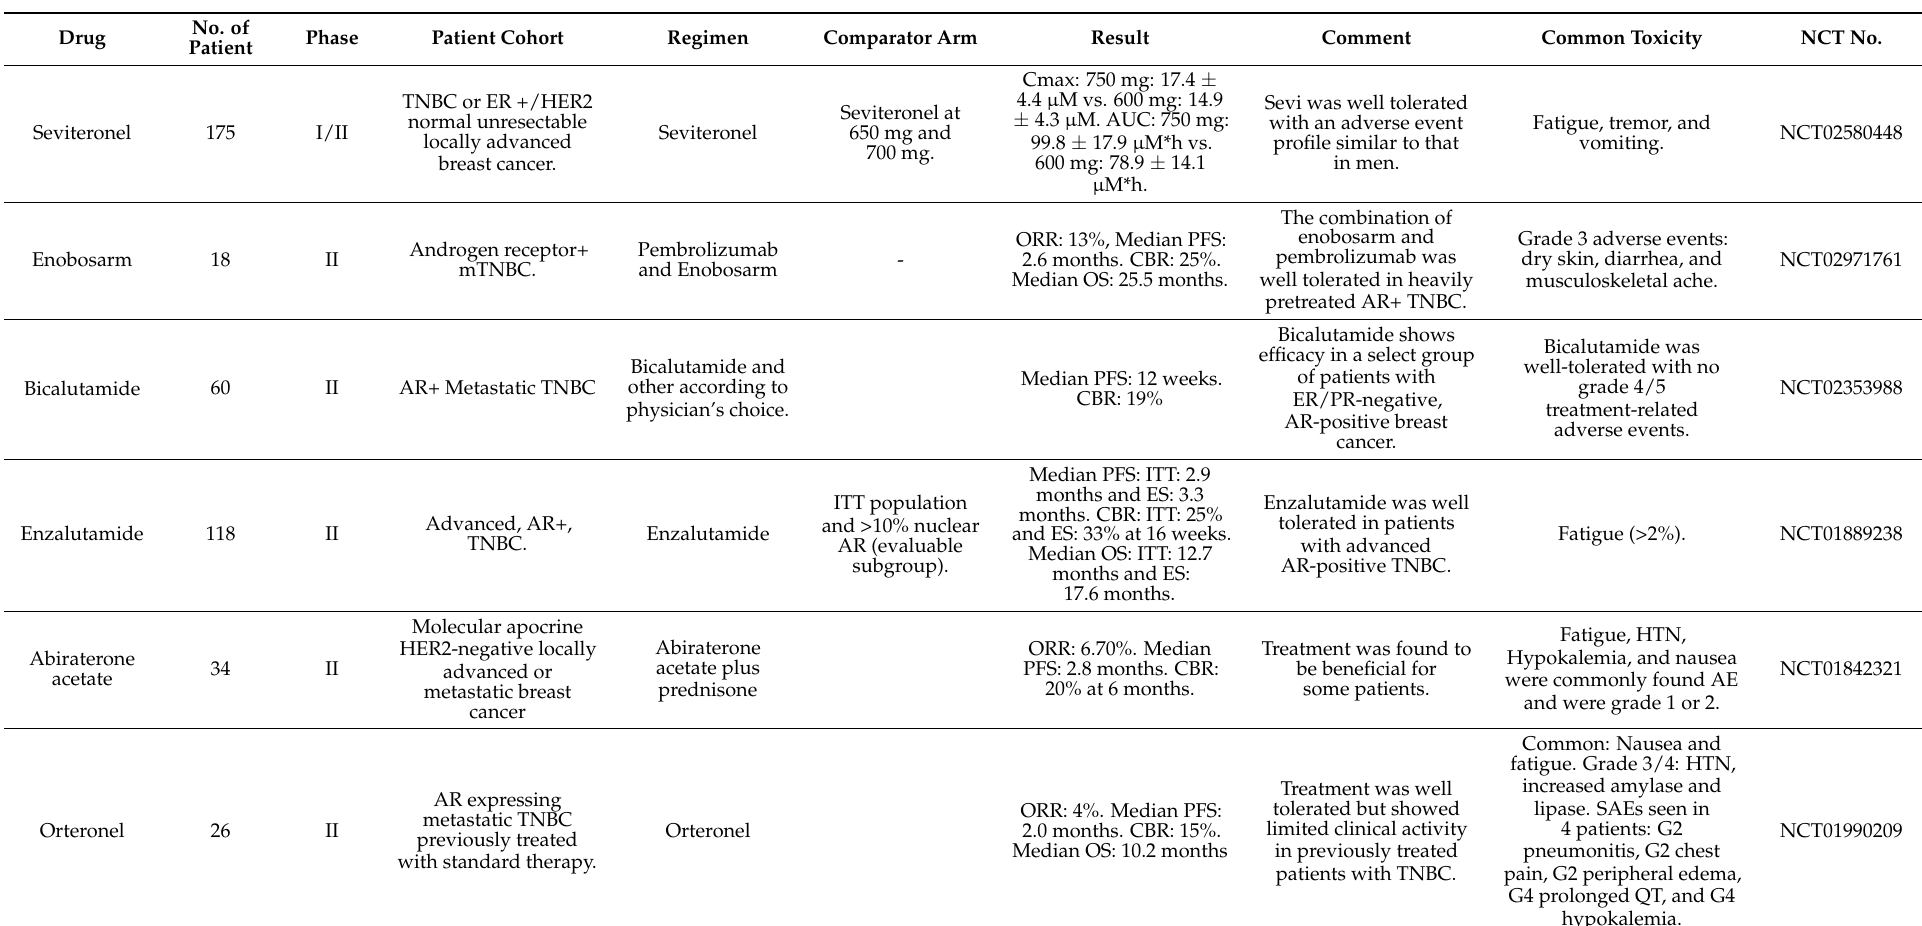
Table 1. List of completed trials presenting the clinical statistics of anti-androgenic